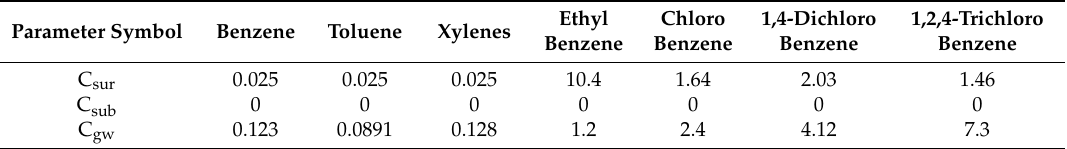
Ethyl Chloro Ethyl Benzene Benzene Benzene